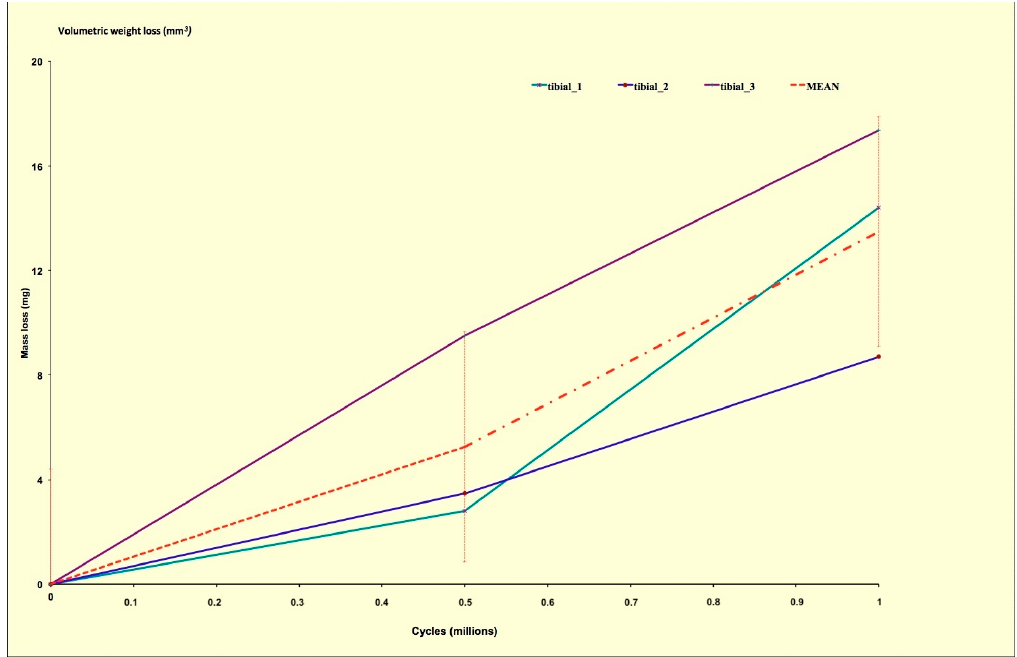
Materials 2019 , 10 , x FOR PEER REVIEW